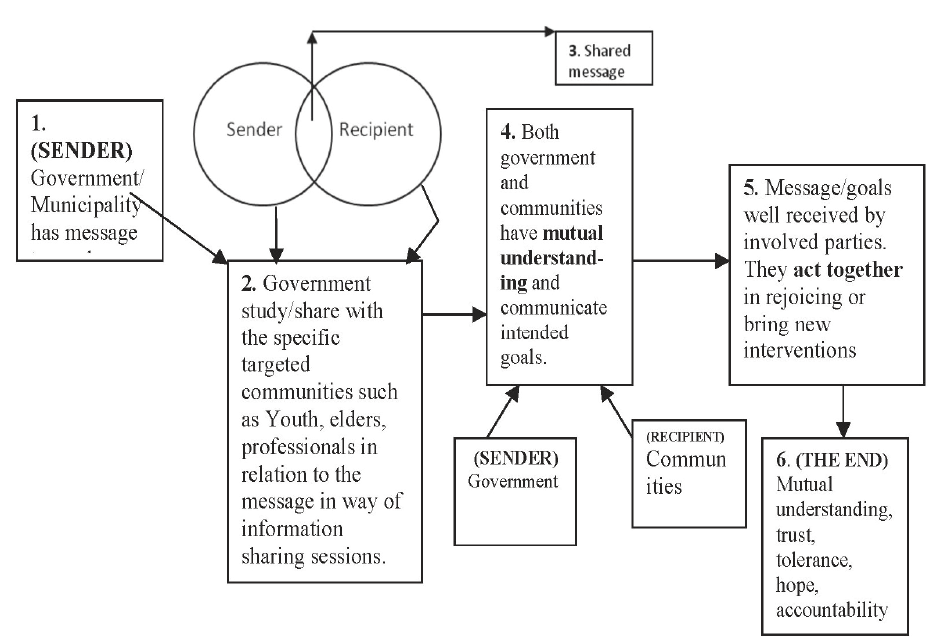
Figure 1: A proposed model for effective communication to enhance Developmental Local Government for rural development amid challenges of